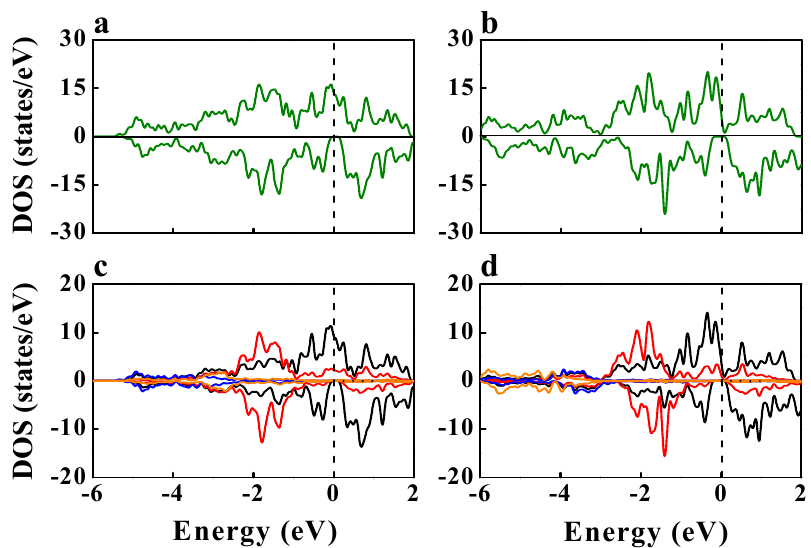
Figure 7. The total density of the states (DOS) of ( a ) Ti 2.25 Co 0.75 Si 0.5 B 0.5 and ( b ) Ti 2.25 Co 0.75 Si 0.5 P 0.5 at the equilibrium lattice parameters. The partial DOS of ( c ) Ti 2.25 Co 0.75 Si 0.5 B 0.5 and ( d ) Ti 2.25 Co 0.75 Si 0.5 P 0.5 at the equilibrium lattice parameters. The black, red, blue, and orange solid lines indicate the Ti-d, Co-d, Si-p, and B (P)-p states, respectively.